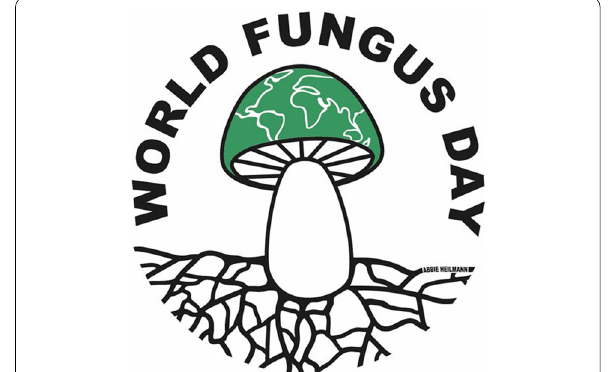
Fig. 3 The World Fungus Day twitter (@FungusDay) icon designed by 17 year-old Abbie